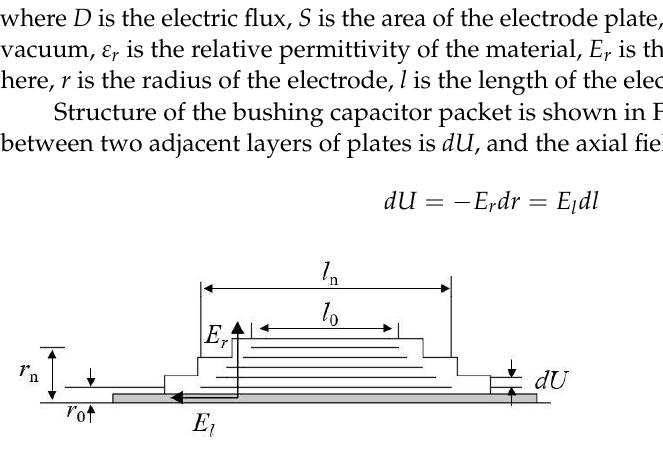
Figure 8. Structure of the bushing capacitor packet.